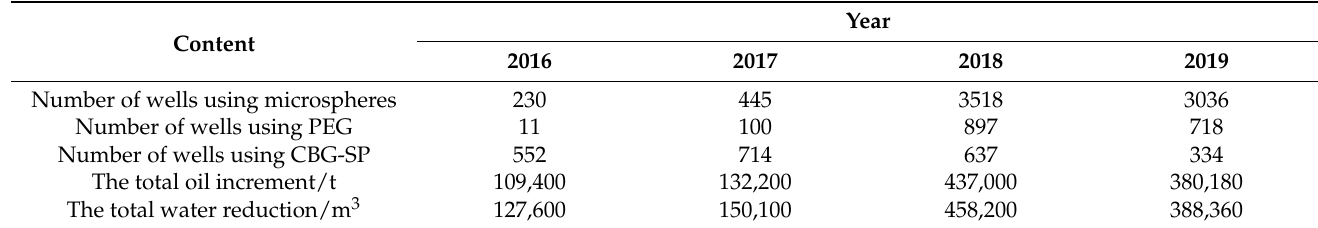
Table 1. Application quantity and effect of PCAs in Changqing Oilfield.